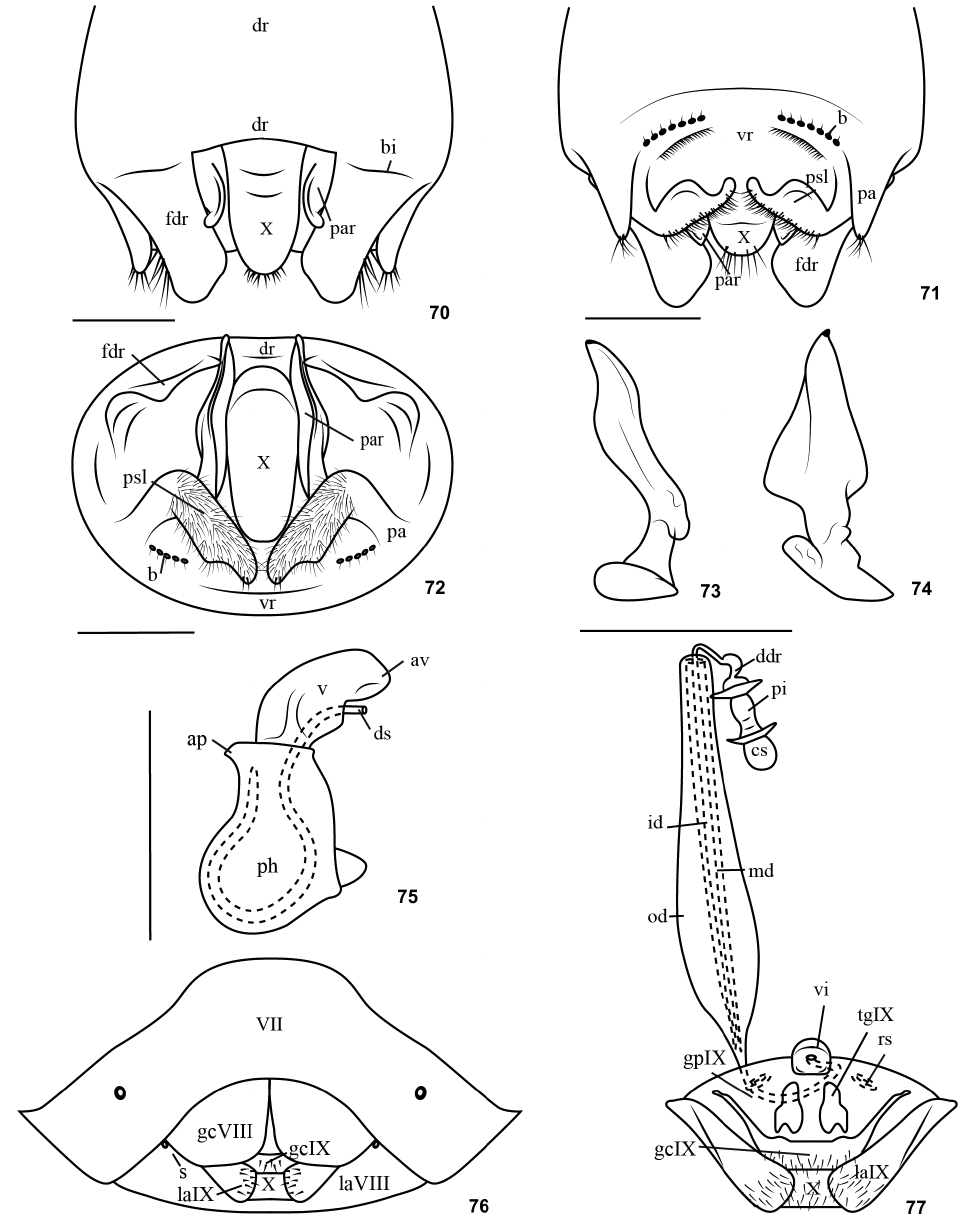
apical projection of phallotheca; av, apical margin of vesica; b, bristles; bi, basal impression of foliaceous expansions; cs, capsula seminalis; ddr, distal ductus receptaculi; dr, dorsal rim; ds, ductus seminis distalis; fdr, foliaceous expansions of dorsal rim; gcVIII, gonocoxites VIII; gcIX, gonocoxites IX; gpVIII, gonapophyses VIII; gpIX, gonapophyses IX; id, internal duct of vesicular area; la8, laterotergites VIII; la9, laterotergites IX; md, median duct of vesicular area; od, outer duct of vesicular area; pa, posterolateral angle; par, paramere; ph, phallotheca; pi, pars intermedialis; psl, projection of superior layer of ventral rim; rs, ring sclerites; s, spiracle; tgIX, thickening of gonapophyses IX; v, vesica; vi, thickening of vaginal intima; vr, ventral rim; VII, urosternite VII; X, segment X. Scale bars: 70–74, 76 = 1 mm; 75, 77 =